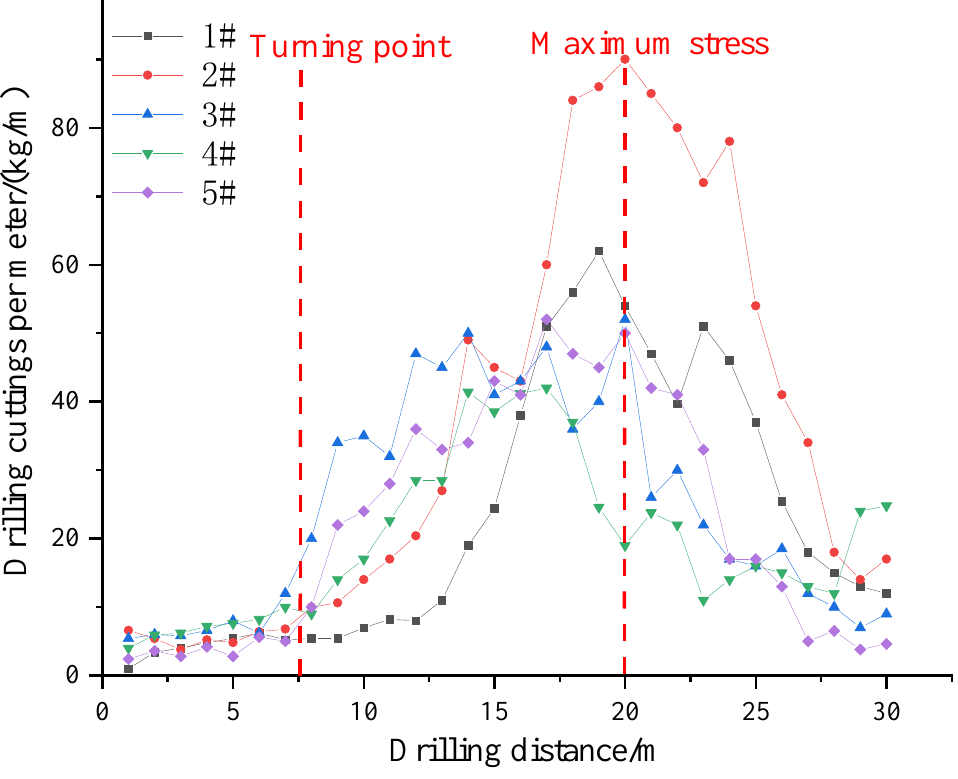
Figure 9. Variation of drilling yield with drilling depth.